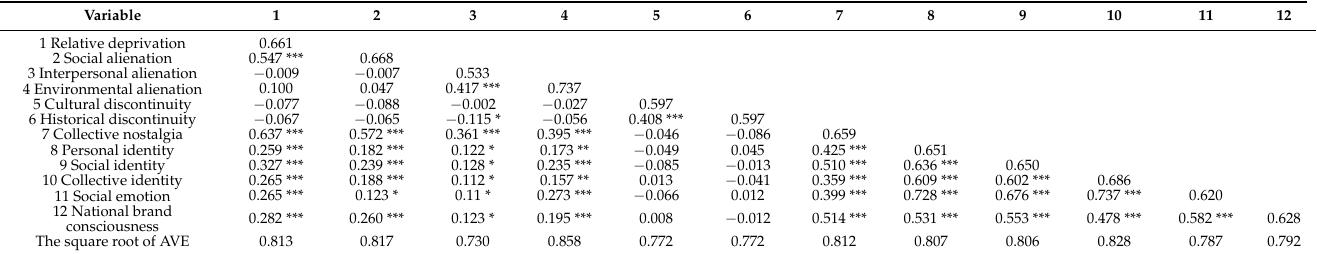
Table 3. Discriminant validity test of